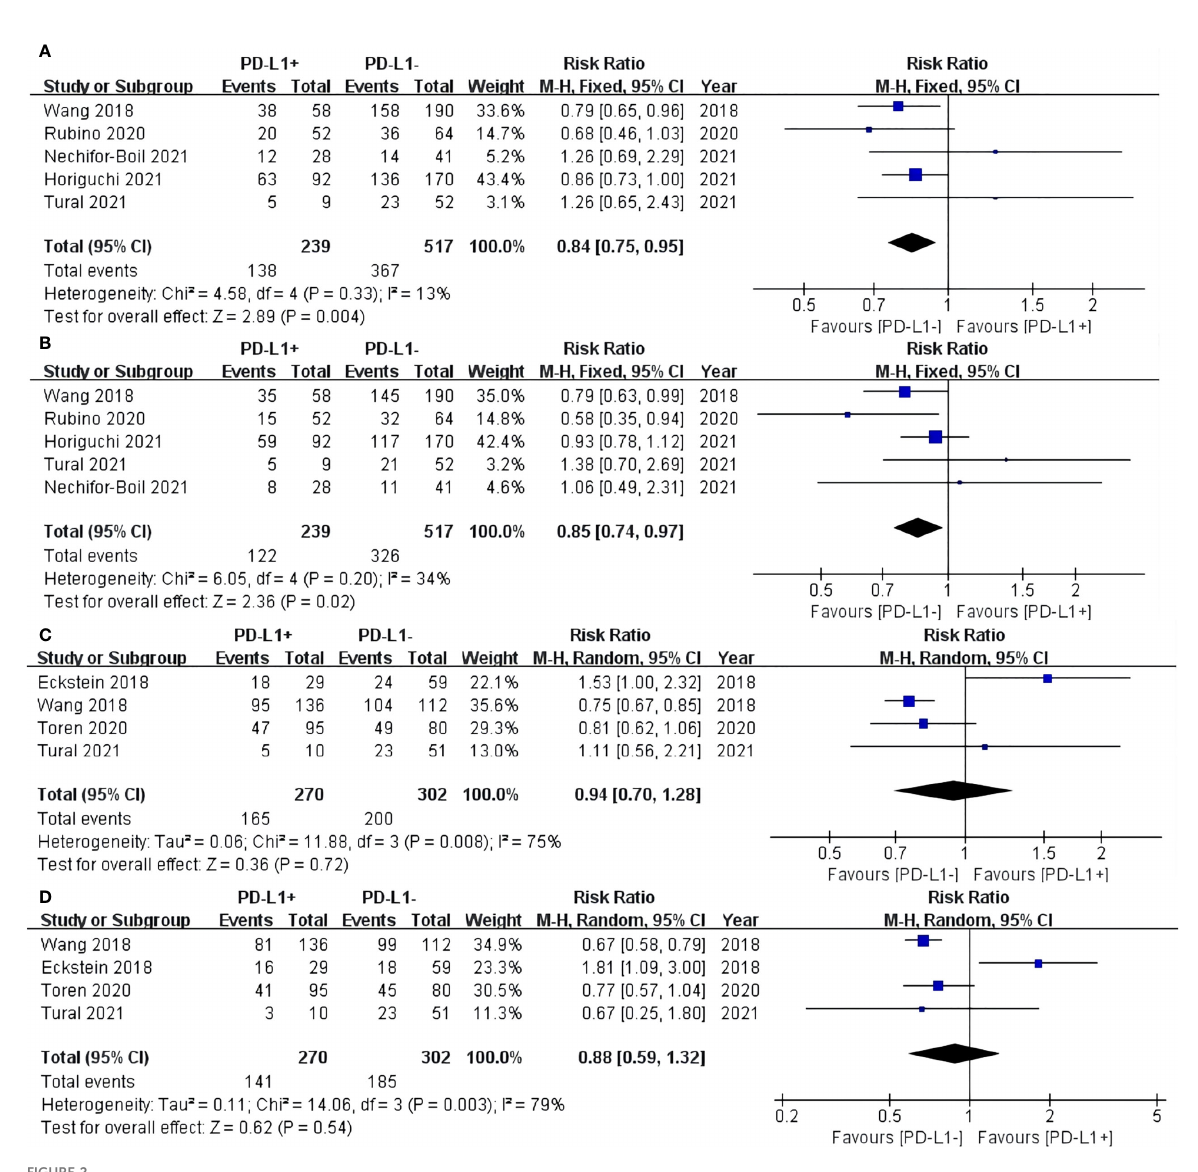
FIGURE 2 Forest plot of overall survival (OS) between the PD-L1 negative and positive groups in tumor cells (TCs): OS after surgery 3 years (A) and 5 years (B) . Forest plot of OS between two group in tumor-in fi ltrating immune cells (ICs): OS after surgery 3 years (C) and 5 years (D)